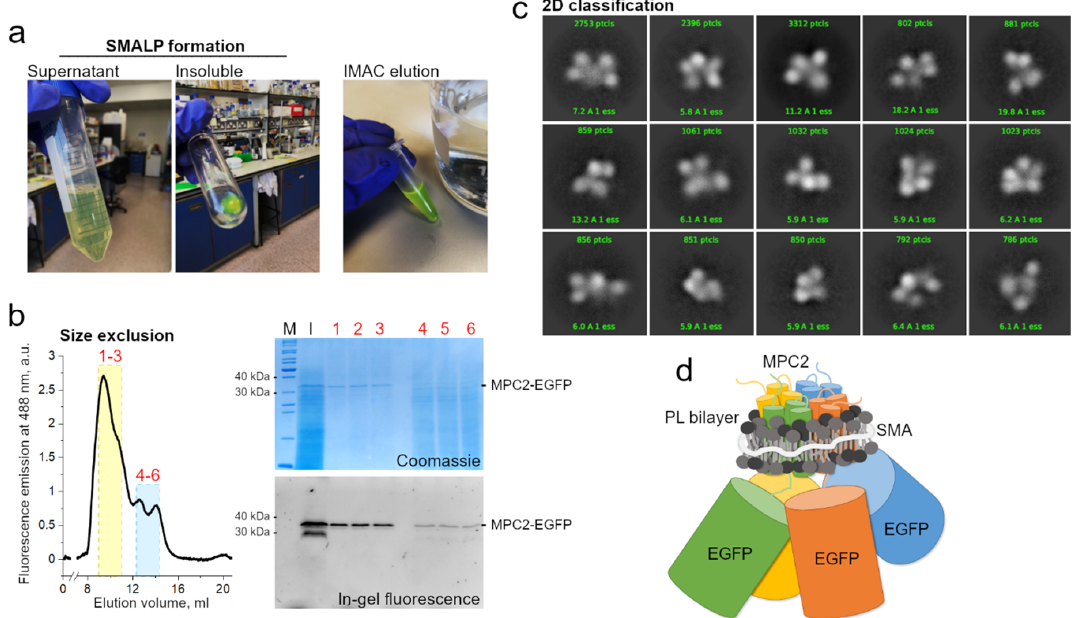
Figure 2. MPC2–EGFP reconstitution into styrene maleic acid (SMA) lipid particles and